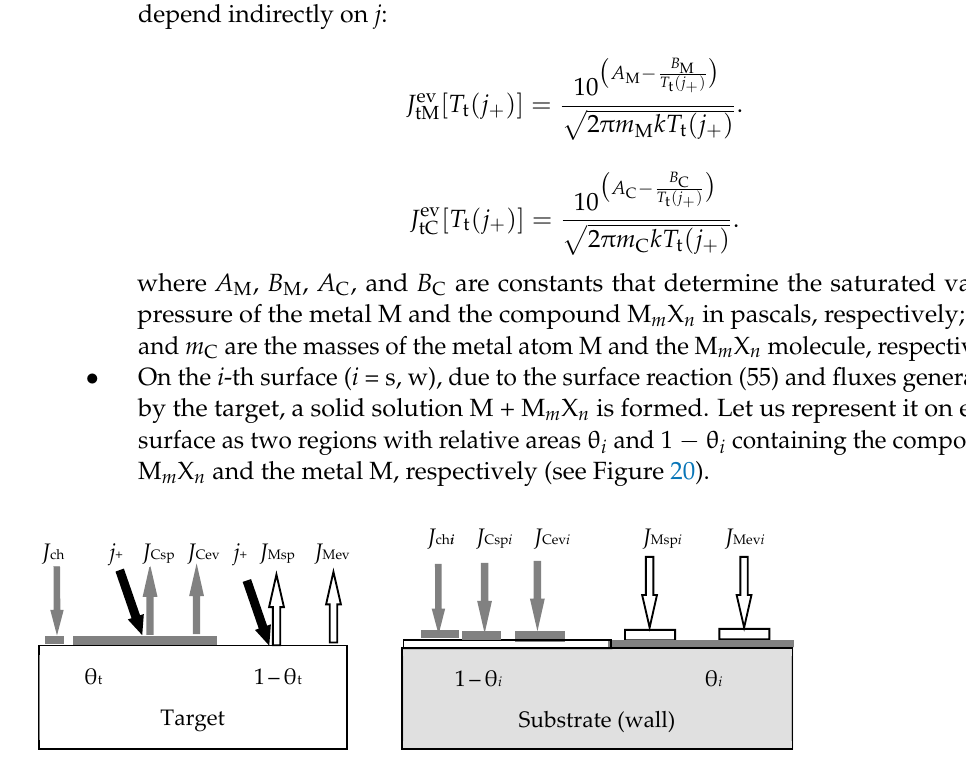
Figure 20. Processes on the surfaces of the target and substrate (wall) during reactive spu tt ering.